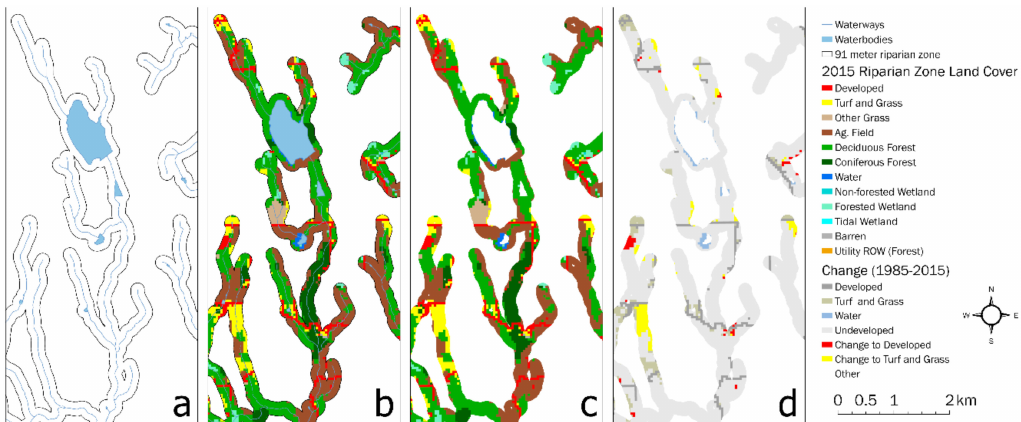
Figure 3. Sample area of the riparian zone analysis that was conducted for the entire state. ( a ) Existing streams and waterbodies (blue) with the 91 m (300 ft) riparian zone (black); ( b ) includes the land cover with the streams, waterbodies, and riparian zone; ( c ) is just the riparian zone land cover for the example area; and ( d ) is the change map for the same riparian